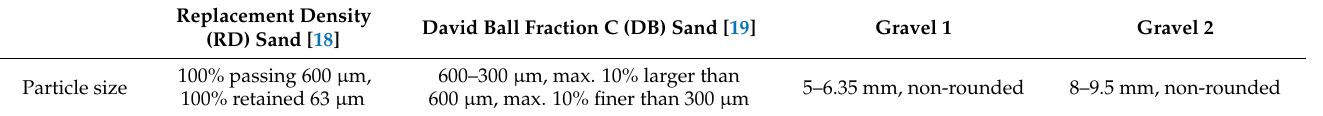
Figure 1. ( a ): Sketch of ultrasonic unit used in this study; ( b ): roundtrip-propagation and reflections of ultrasound waves from front/back surfaces of the plate and the soil surface; ( c ): An A-scan example of ultrasonic measurement containing three reflections from three surfaces in ( b ).